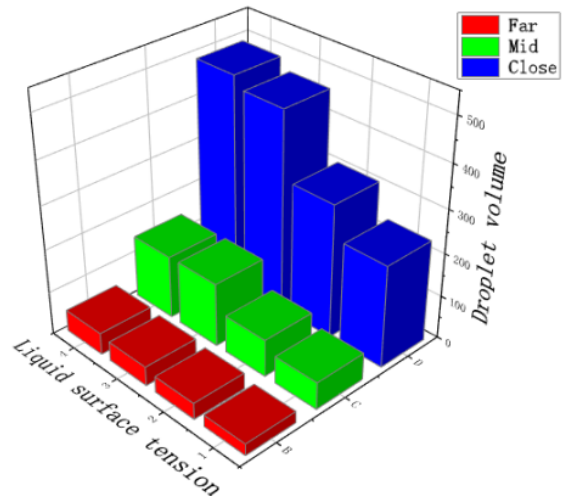
Figure 15. The canopy droplet deposition volume under different liquid surface tensions.